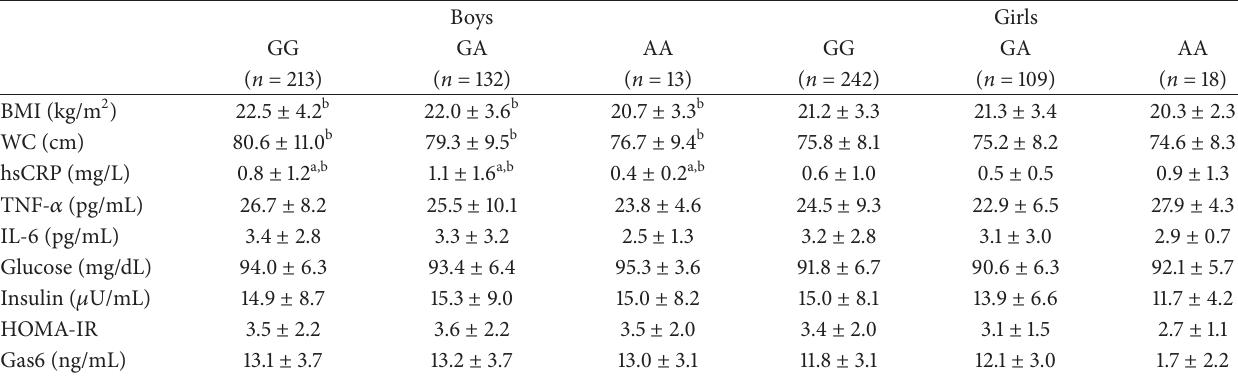
Table 2: Anthropometric and biochemical data with different GAS6 rs8191974 genotypes among boys and girls.